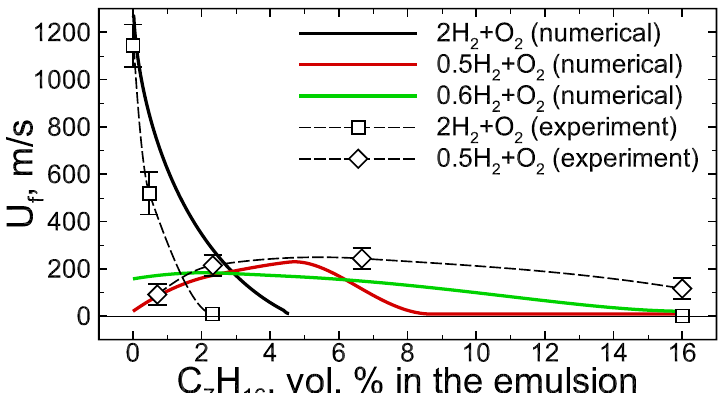
Figure 4. Averaged flame speed dependence on the heptane content in the initial emulsion at various hydrogen content in the foaming gas mixture. Experimental data are taken from [19]. Error bars are estimated on the base of three independent tests with the same